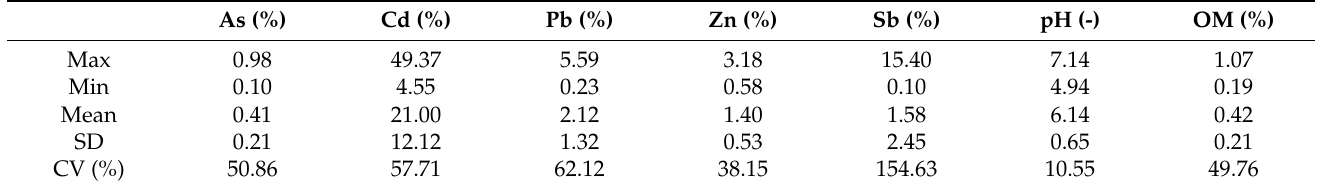
Table 5. The bioavailable fractions of the heavy metals and metalloids in profile soil